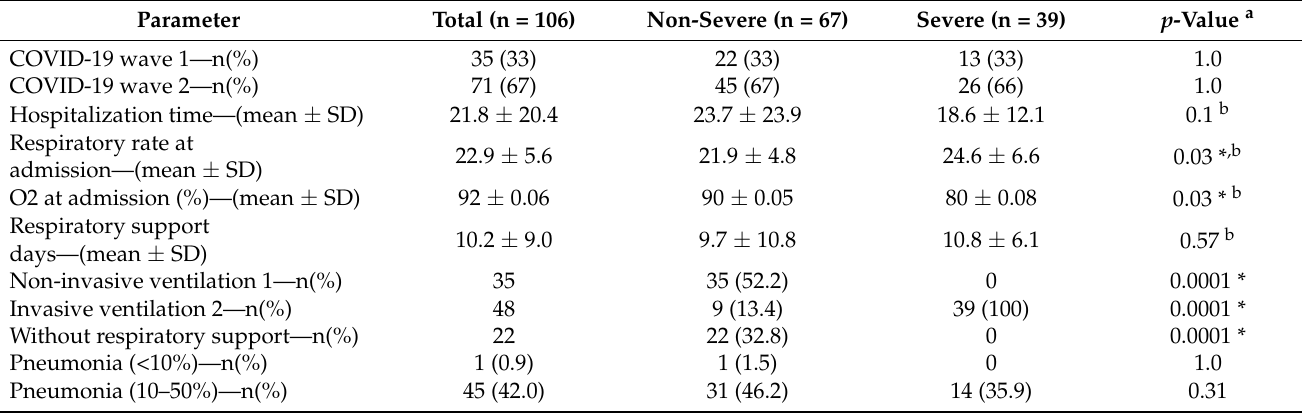
Table 5. Course of infection and